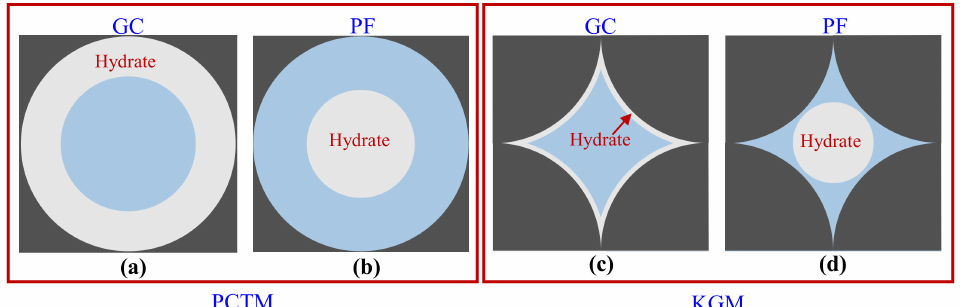
Figure 1. Idealized pore space characteristics and hydrate pore habits in porous media for permeabil- ity conceptual models. ( a , b ) refer to tube-wall coating and tube-center occupying hydrates within a cylindrical tube; ( c , d ) refer to grain-coating and pore-filling hydrates within an intergranular